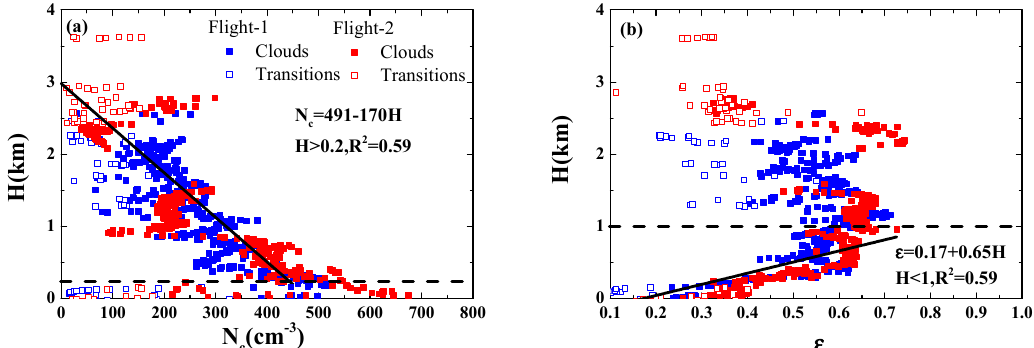
Figure 3. Relationships of cloud droplet concentration ( N c ) and relative dispersion ( ε ) to the height above cloud-base (H), corresponding to ( a ) and ( b ), respectively.